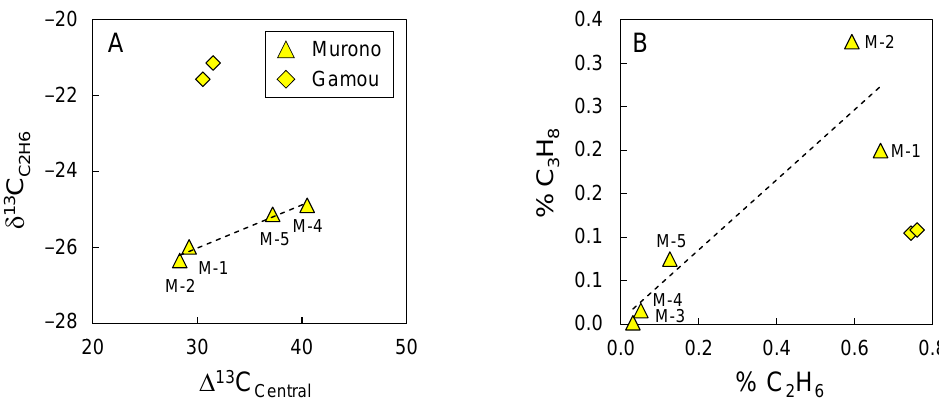
Figure 5. Relationship between ethane and propane: ( A ) isotope composition and ( B ) relative concentration %. Dotted lines indicate best fit for linear regression for Murono samples only. Sample numbers for Murono are indicated.